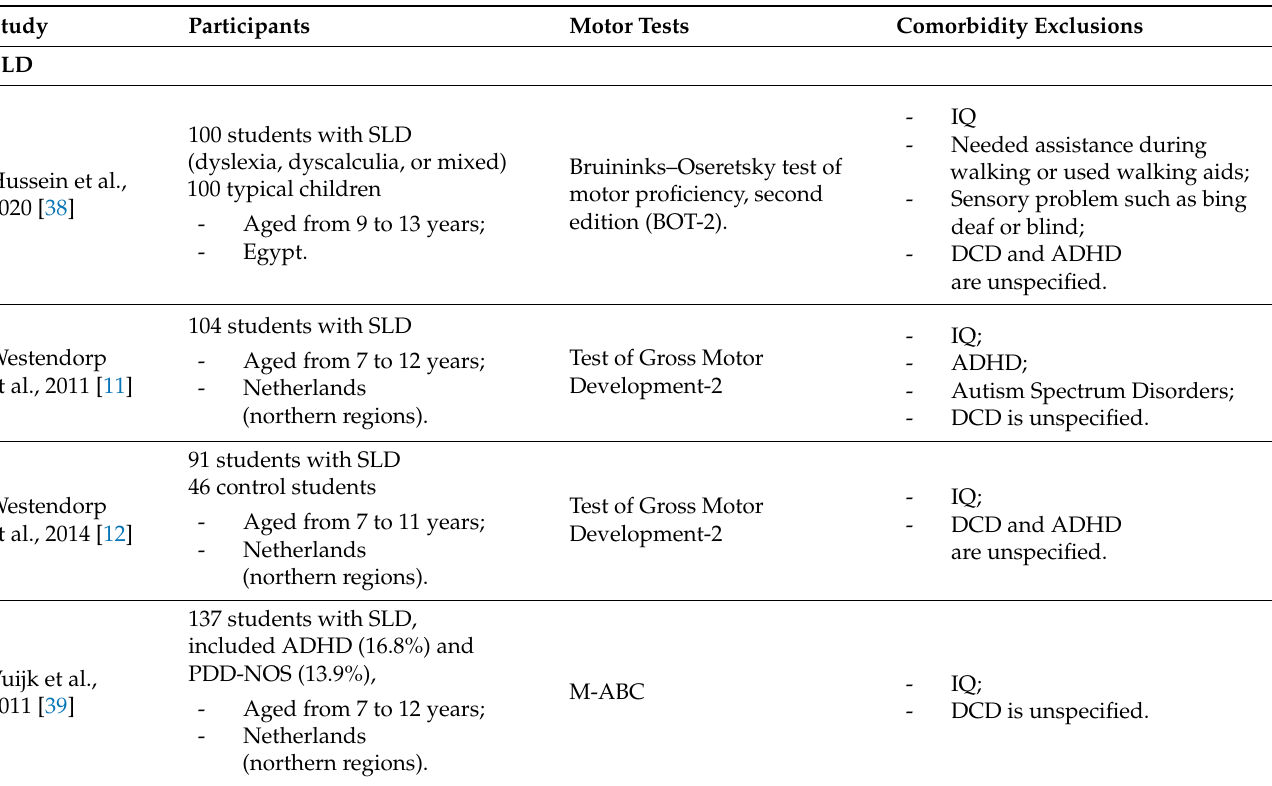
Table 1. Includes sample descriptions, motor tests used, and comorbidity exclusions reported by authors of 36 of the reviewed studies. The ** represents studies that excluded ADHD and other neurologic or motor disorders from their sample, and the * represents studies that included comorbidities but controlled for them in their